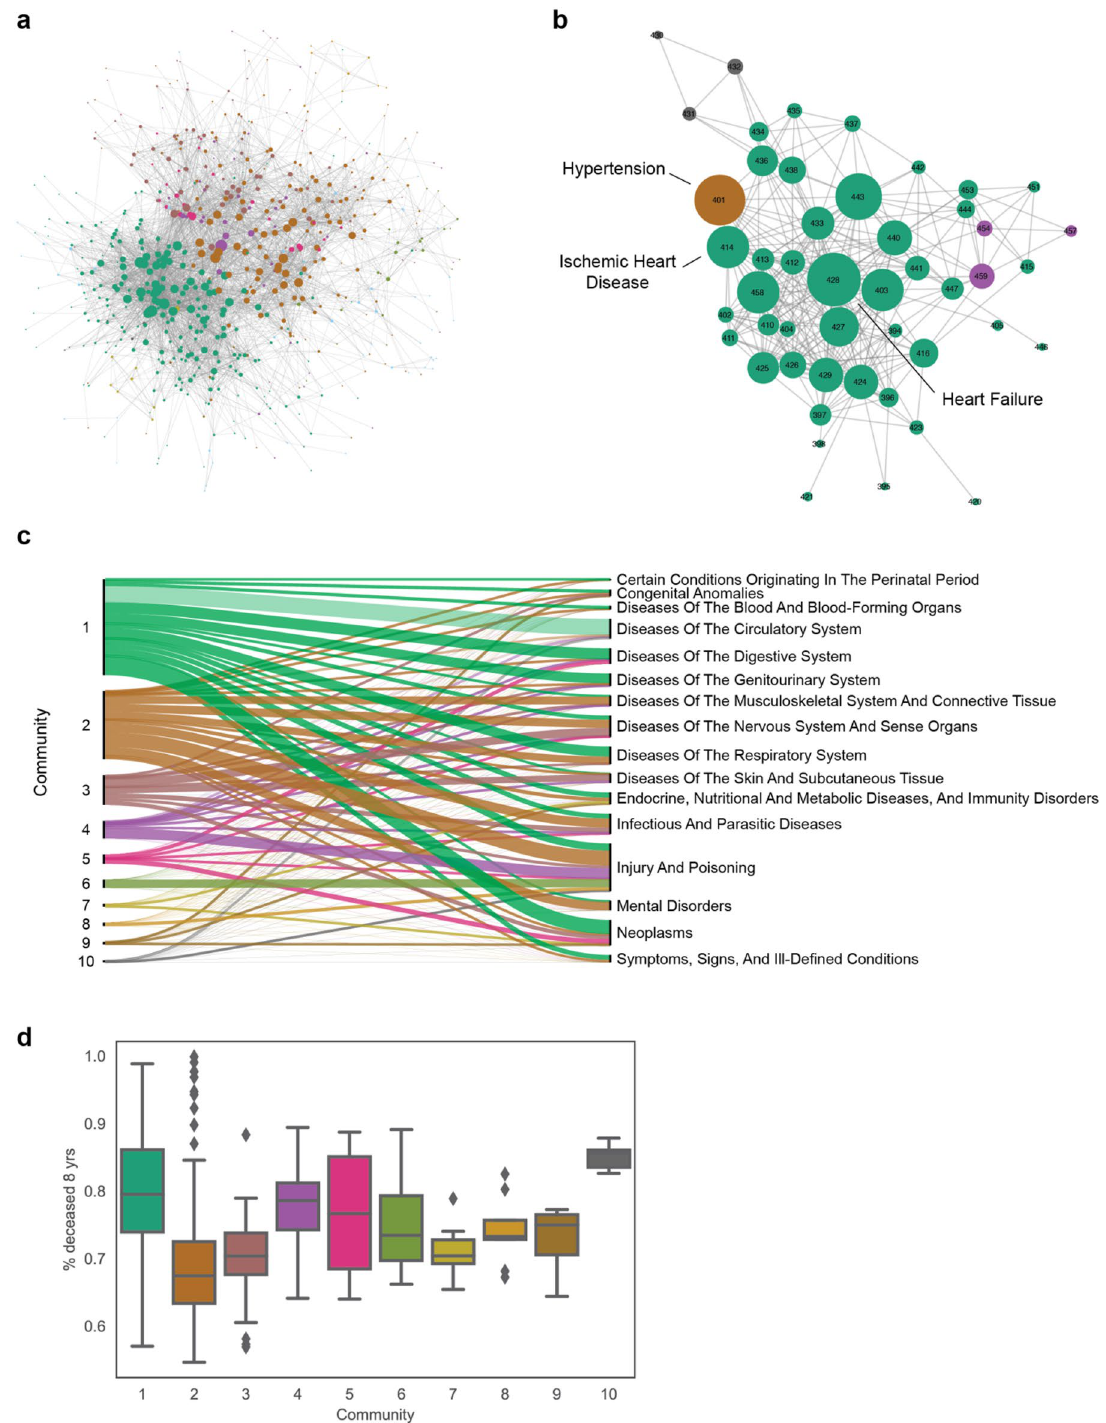
Figure 3. Communities. ( a ) Visualization of TDN with colors representing the different communities detected using InfoMap. ( b ) The community assignments for diagnoses in the ICD-9 chapter “Diseases of The Circulatory System”. ( c ) Alluvial diagrams representing the re-assignment of diseases from different ICD-9 chapters into the detected communities. ( d ) Distribution of % of deceased patients after 8 years of first diagnosis for diseases assigned in the different